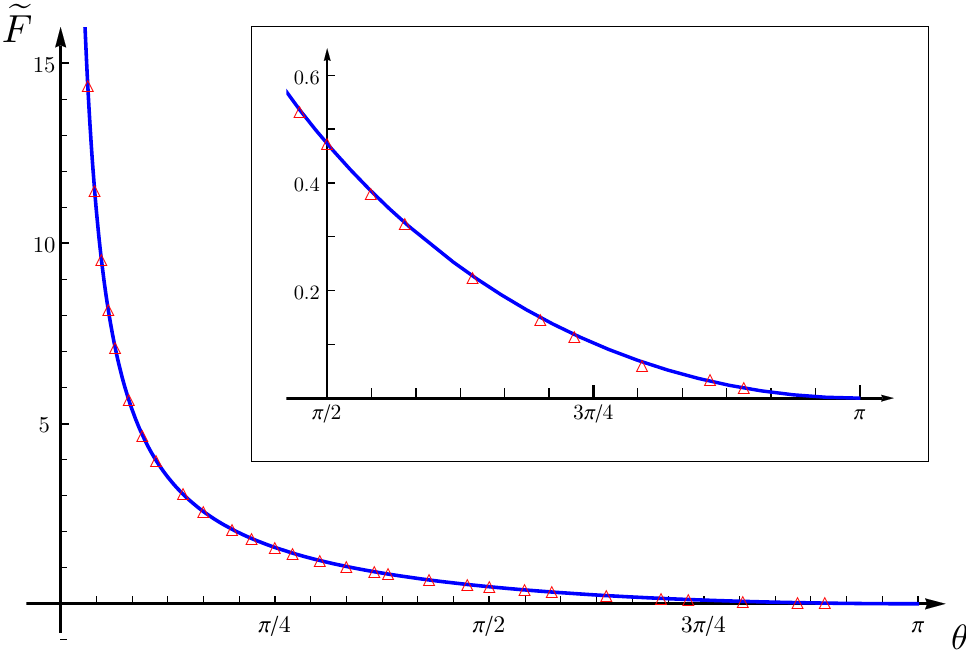
Figure 4 . Corner function for a vertex with two edges in AdS 4 /CFT 3 . The blue curve corresponds to the analytic expression given by (3.2) and (3.4) found in [27]. The points labeled by the red triangles have been found through the numerical analysis based on Surface Evolver (see section